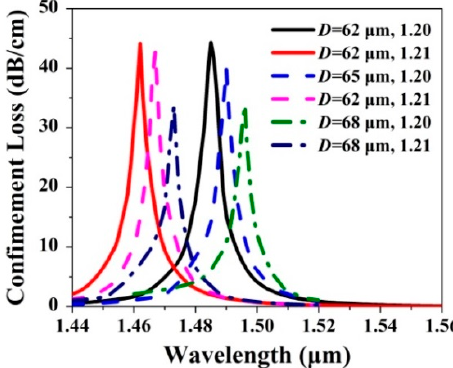
Figure 6. The confinement loss spectra of the x -pol core mode when D increases from 62 to 68 μ m and the RI of the filled analyte is chosen as 1.20 and 1.21, respectively. Table 1. Summary of the influences of the fiber structure parameters on the sensing performances. Increase of the Structure